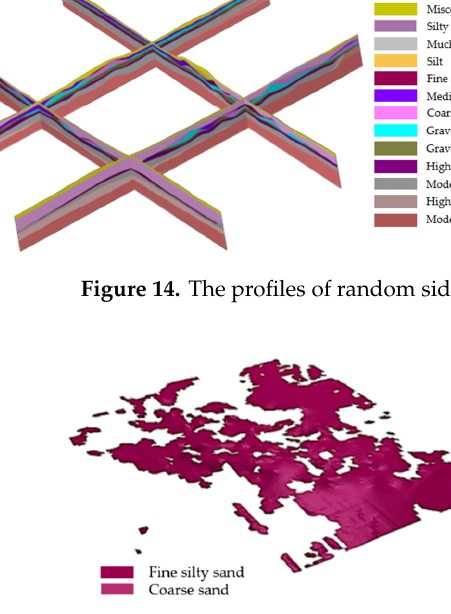
Figure 15. Exclusion of the erroneous stratigraphic body with a thickness of zero.